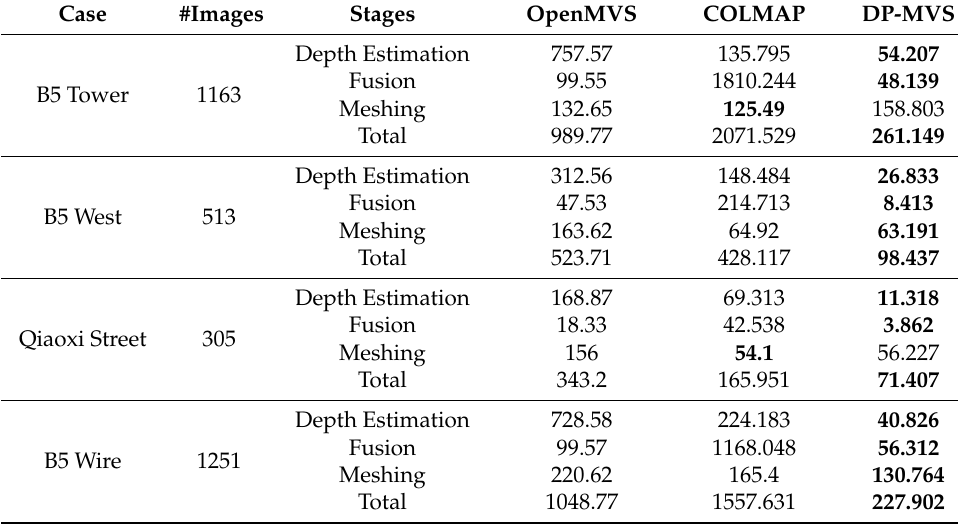
Table 3. We report detailed time consumptions of our DP-MVS system and other SOTA methods including OpenMVS [56] and COLMAP [26] in all the steps of cases “B5 Tower”, “B5 West”, “Qiaoxi Street” and “B5 Wire”. All the time consumptions are calculated by minutes, with bold format highlighting the fastest time of all the